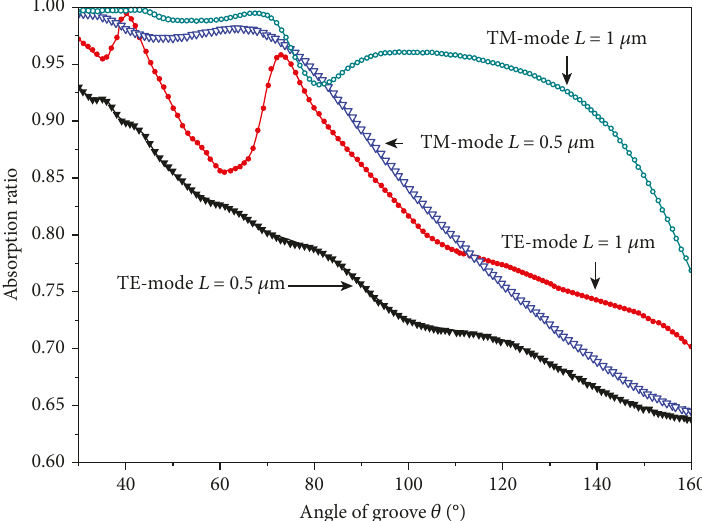
Figure 5: Varying curve of absorptivity along with the intersection angle of the V-type groove